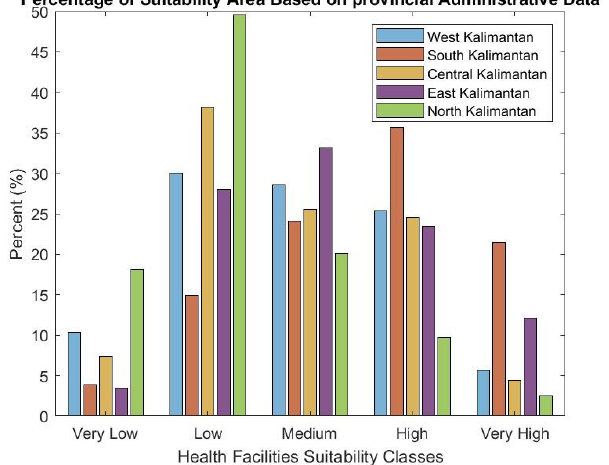
Figure 7 Percentage of suitability area based on provincial administrative